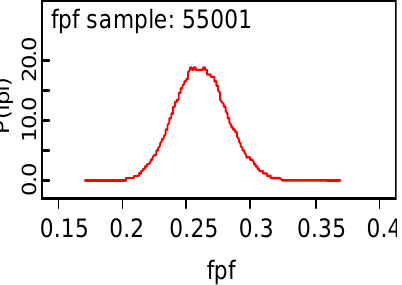
Figure 1. Posterior density of the false positive fraction. fpf sample: 55001